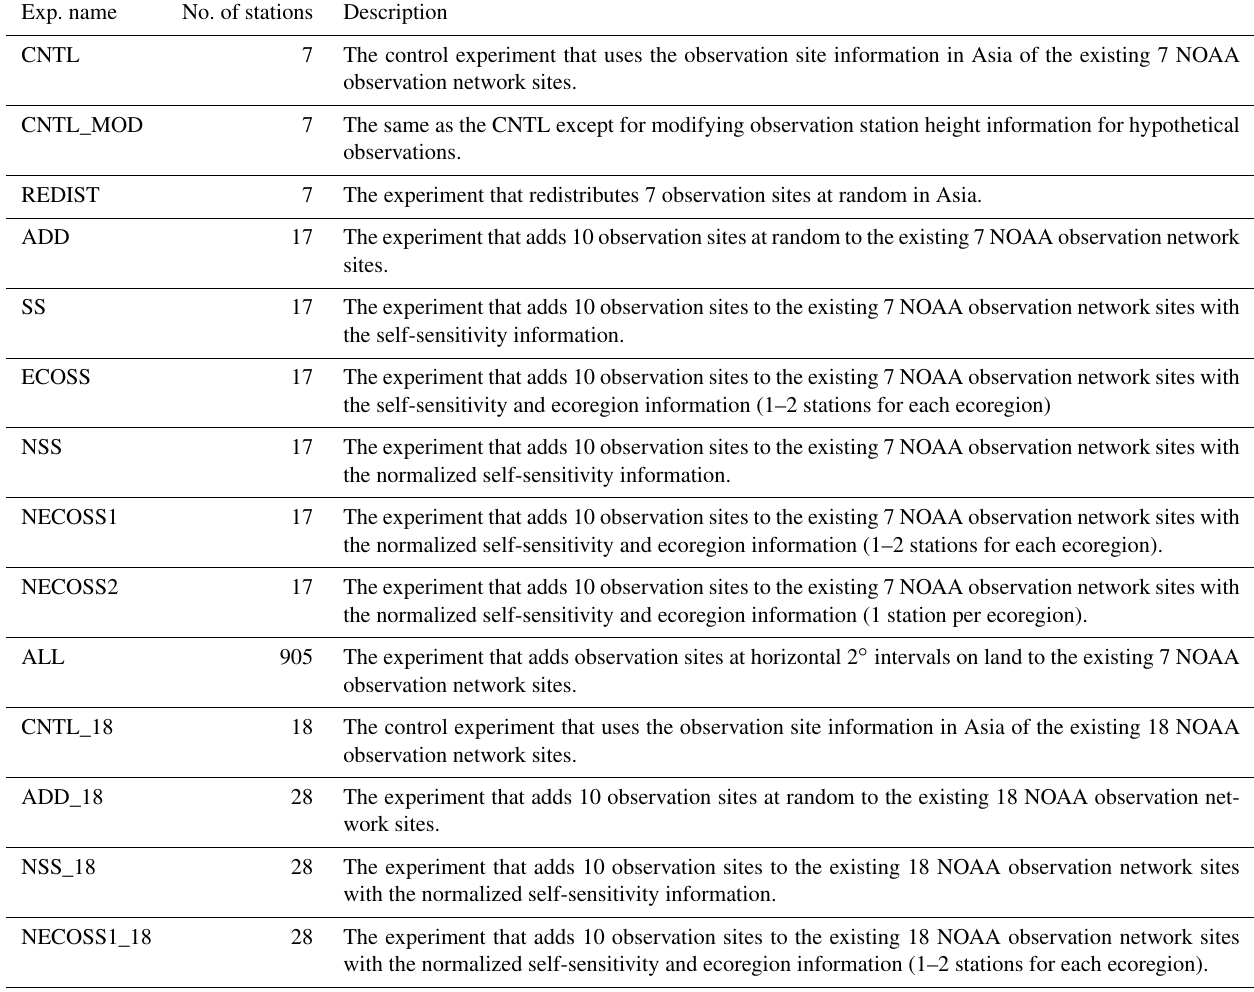
Table 2. Brief description of the experiments conducted in this